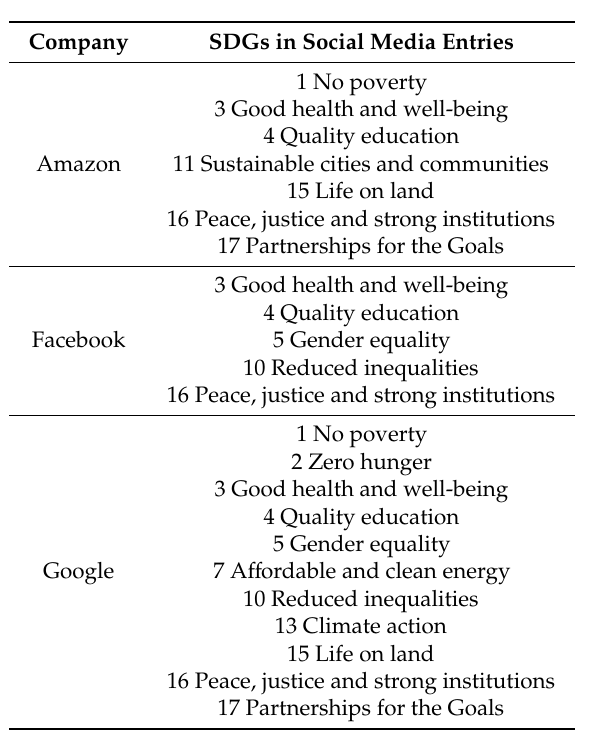
Table 3. Subjects of entries concerning Sustainable Development Goals (SDGs) in the surveyed companies’ social